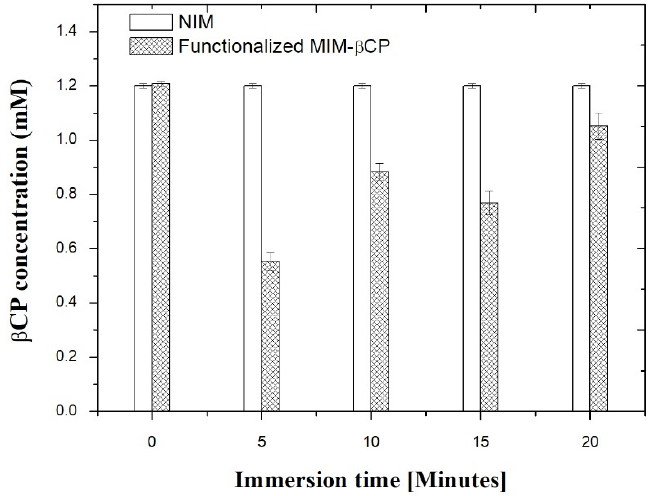
Figure 9. β CP concentration versus immersion time at 5 min intervals using the functionalized MIM– β CP and NIM.